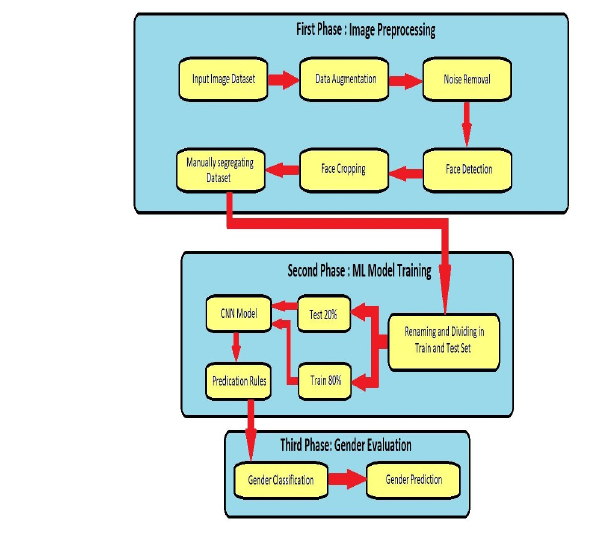
Figure 6. Real Time Gender Classification